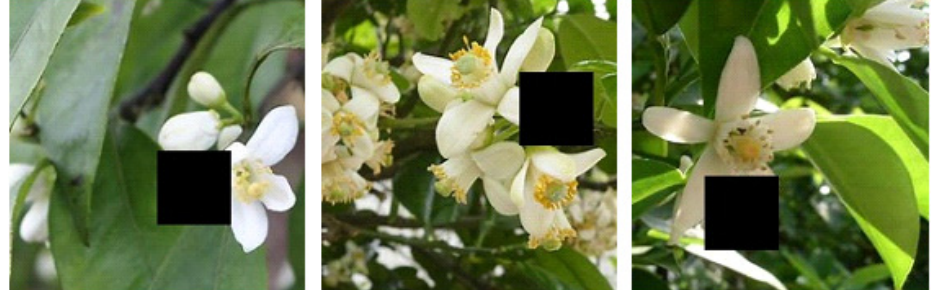
Figure 2. Figures after using the Cutout method.